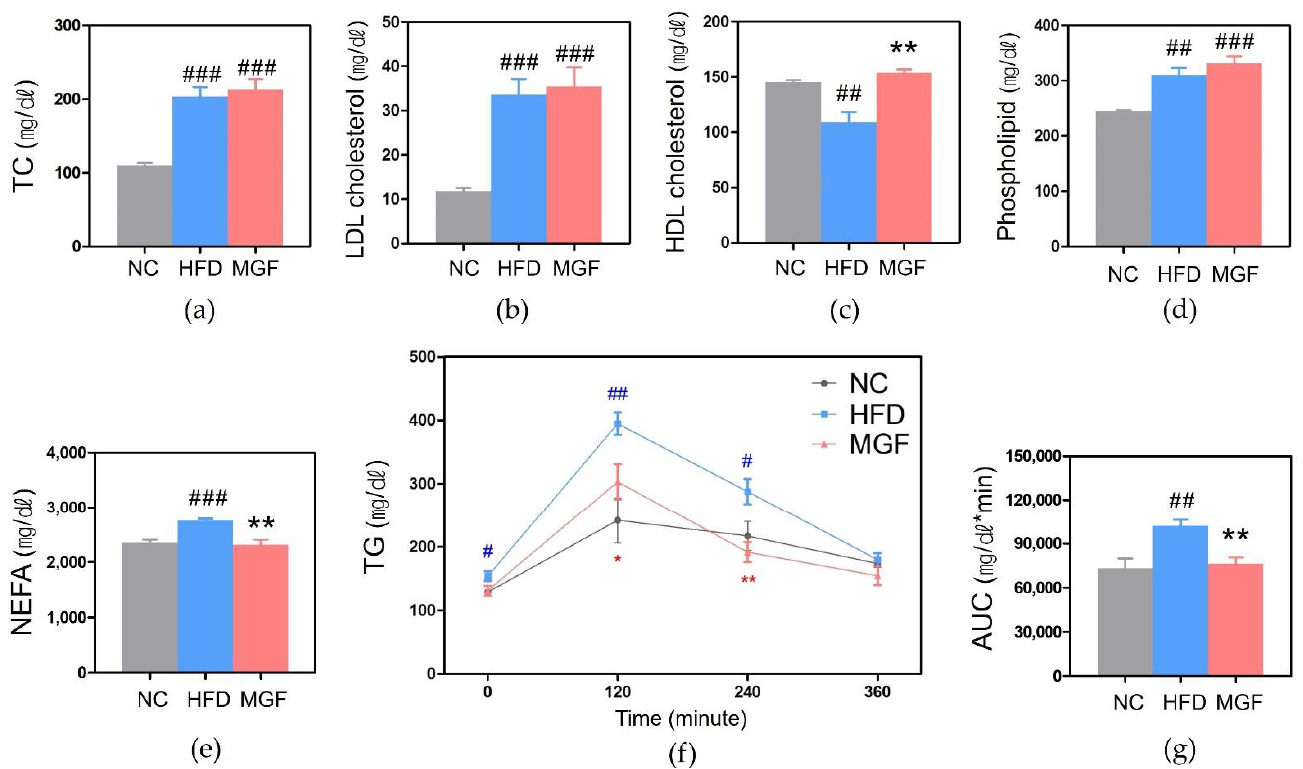
Figure 5. Lipid profiles of each experimental group. ( a ) Total cholesterol (TC). ( b ) LDL cholesterol. ( c ) HDL cholesterol. ( d ) Phospholipid. ( e ) Nonesterified fatty acids (NEFA). ( f ) OFTT. ( g ) AUC of OFTT. Data are expressed as mean ± standard error of mean. # p < 0.05, ## p < 0.01, and ### p < 0.001 indicate the results of comparison with the NC group, and * p < 0.05 and ** p < 0.01 indicate the results of comparison with the HFD group. NC, normal chow; HFD, high-fat diet; MGF, HFD + MGF 150 mg/kg/day; MGF, mangiferin; TC, total cholesterol; LDL, low-density lipoprotein; HDL, high- density lipoprotein; TG, triglyceride; AUC, area under the curve; OFTT, oral fat tolerance test.